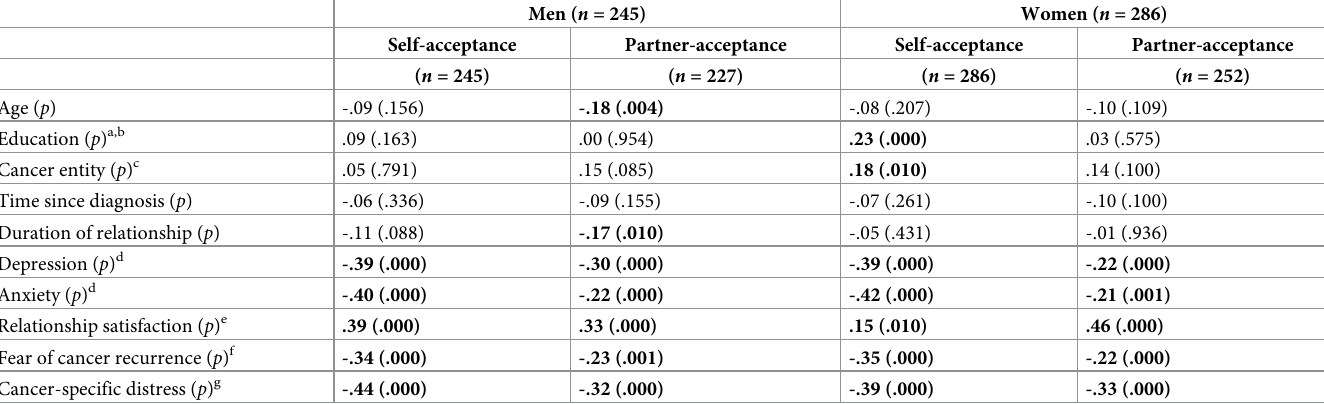
Table 2. Correlations with self-acceptance and partner-acceptance in cancer patients by sex ( N = 531).